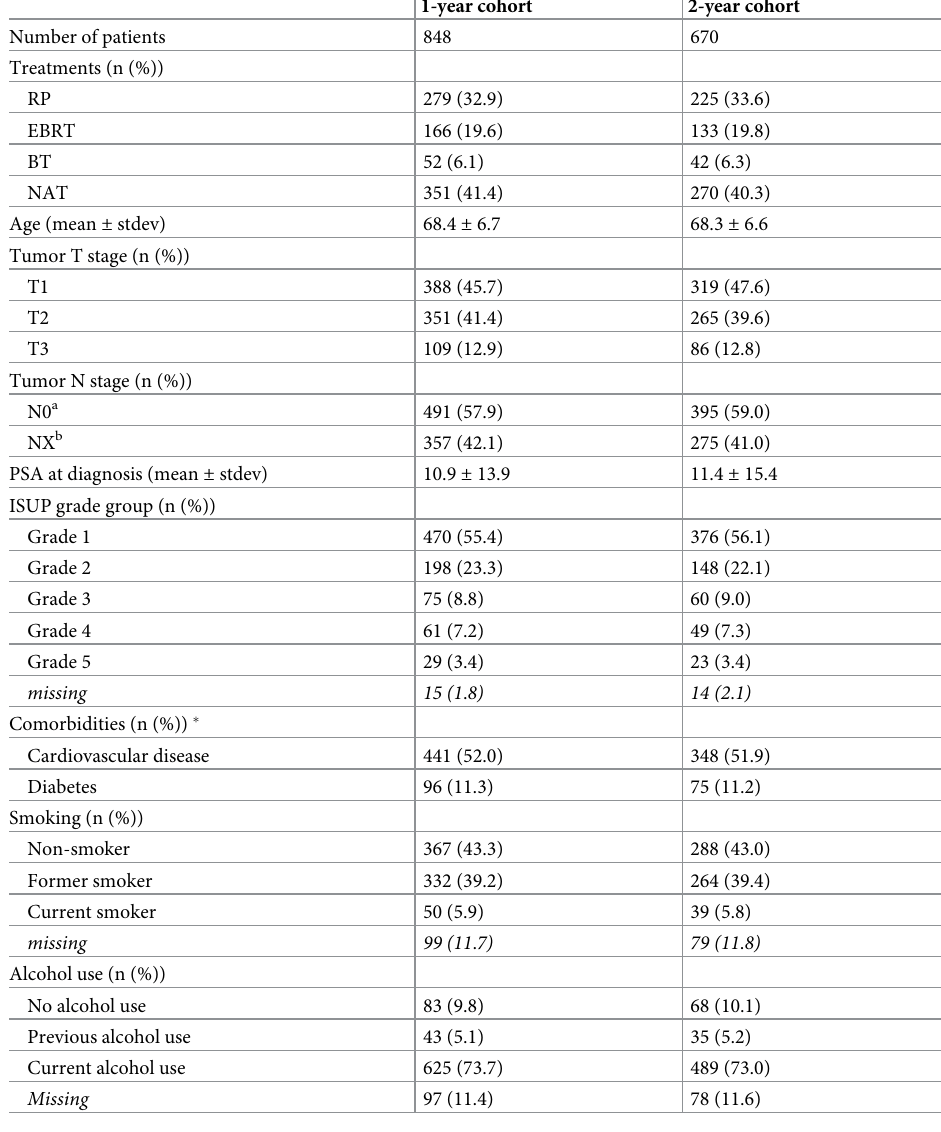
Table 1. Description of the patient characteristics for the 1-year and the 2-year cohort included in our ProZIB sub